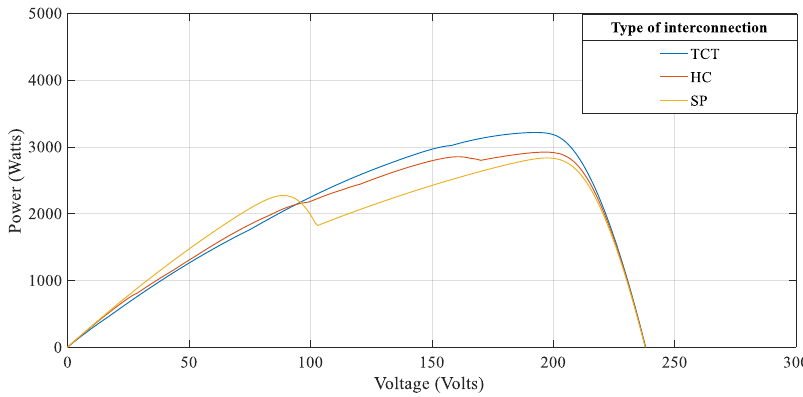
Figure 12. P-V curve for non- uniform shading ‘F3′ (thin-film PV).